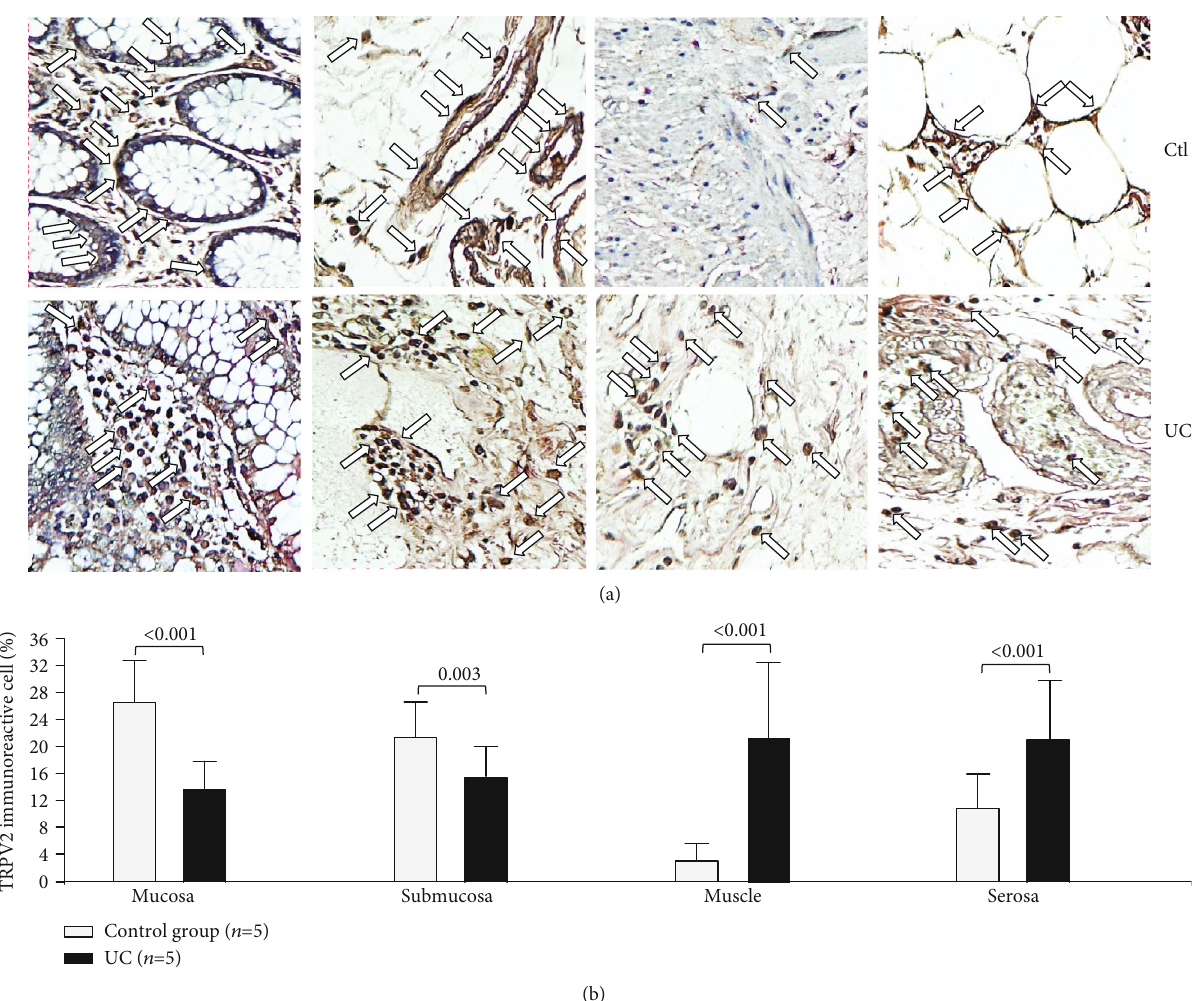
Figure 2: Protein expression of TRPV2 in intestinal tissue from patients with UC and controls. TRPV2 protein expression in colonic tissue samples obtained from patients with severe ulcerative colitis and nonin fl amed colonic tissue. (a) Immunoperoxidase photomicrographs of ulcerative colitis (lower panel, n = 5 ) and non-IBD colonic tissue (control; upper panel, n = 5 ). Arrows indicate TRPV2 immunoreactive cells in the mucosa, submucosa muscular, and serosa layers. Original magni fi cation was × 320. (b) TRPV2-producing cell percentage in nonin fl amed colonic tissues (control, n = 5 ) and active UC patients ( n = 5 ) is shown in